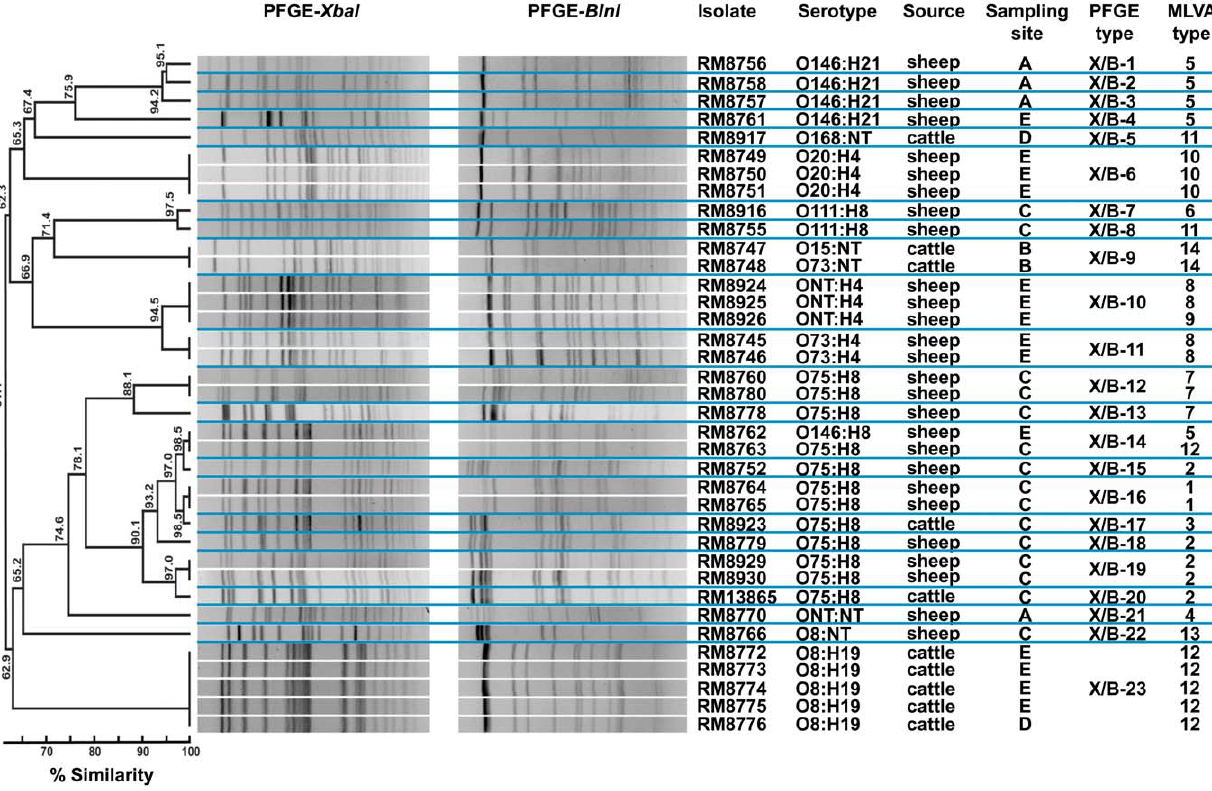
Figure 4. Analysis of the genetic relatedness among the non-O157 STEC isolates by PFGE and MLVA methods. Dendograms of the combined PFGE types with Xba I and Bnl I restriction enzymes were constructed using Bionumerics software v6.1 with the Dice coefficient and the UPGMA method. MLVA types were designated to each unique profile after analysis of tandem repeats in 10 genomic loci using Bionumerics software. doi:10.1371/journal.pone.0051565.g004 PLOS ONE |